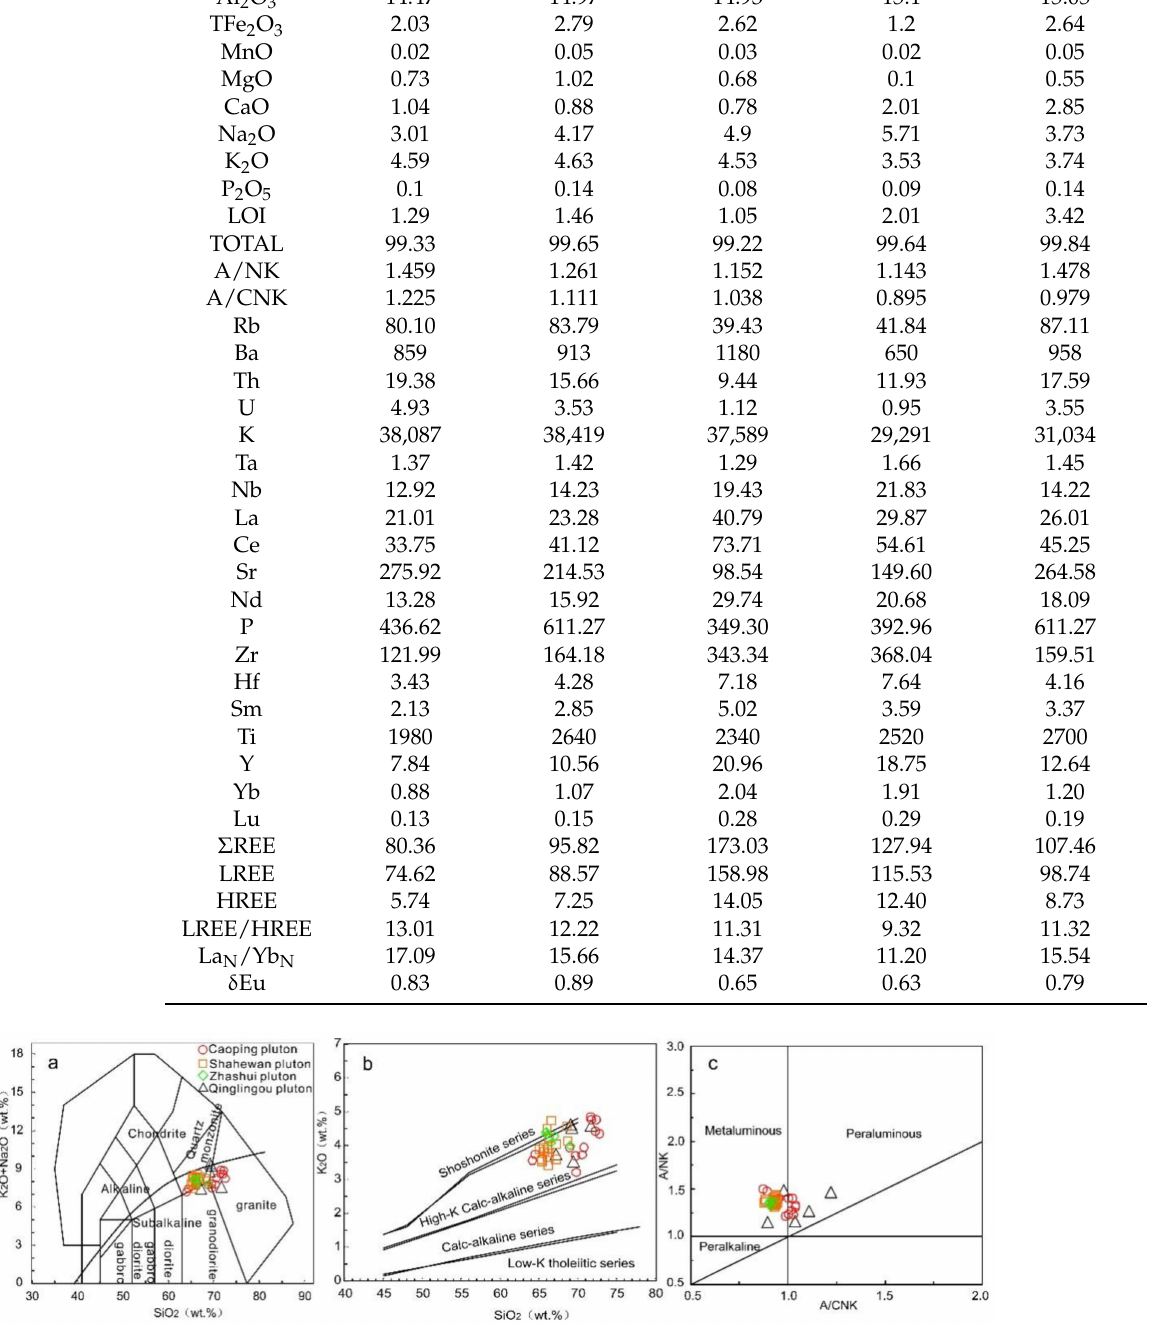
Figure 5. ( a ) Plots of Na 2 O + K 2 O vs. SiO 2 [30], ( b ) K 2 O vs. SiO 2 [31], and ( c ) A/NK [molar ratio Al 2 O 3 /(Na 2 O + K 2 O)] vs. A/CNK [molar ratio Al 2 O 3 /(CaO + Na 2 O + K 2 O)] [32]; Granitoid data of the Zhashui-Shanyang district are from